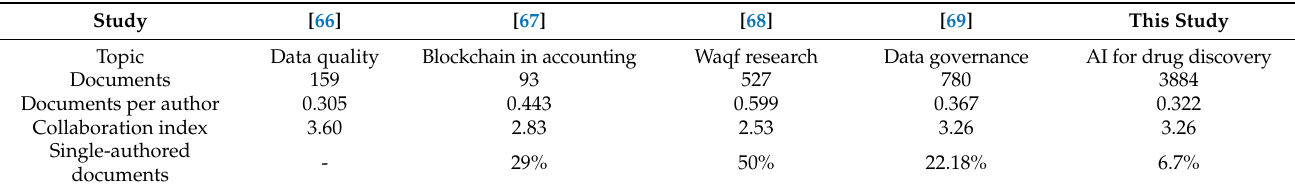
Table 2. Comparison of different bibliometric